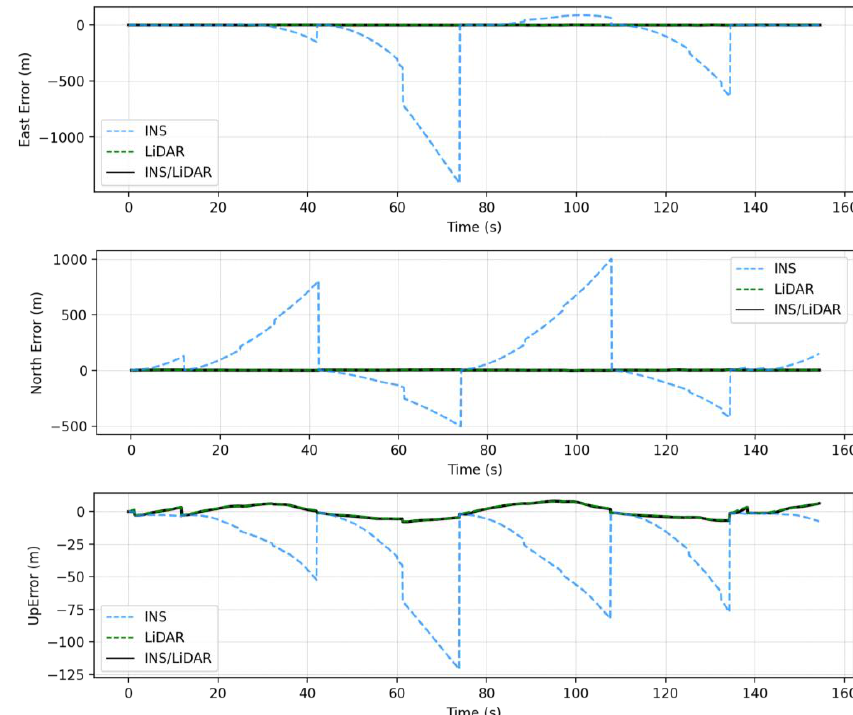
Figure 13. GNSS assisted: position errors (ENU).